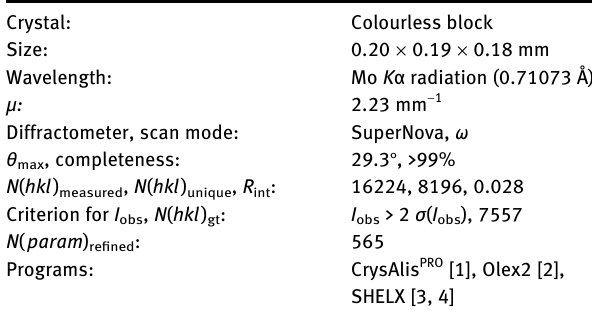
Table  : Data collection and